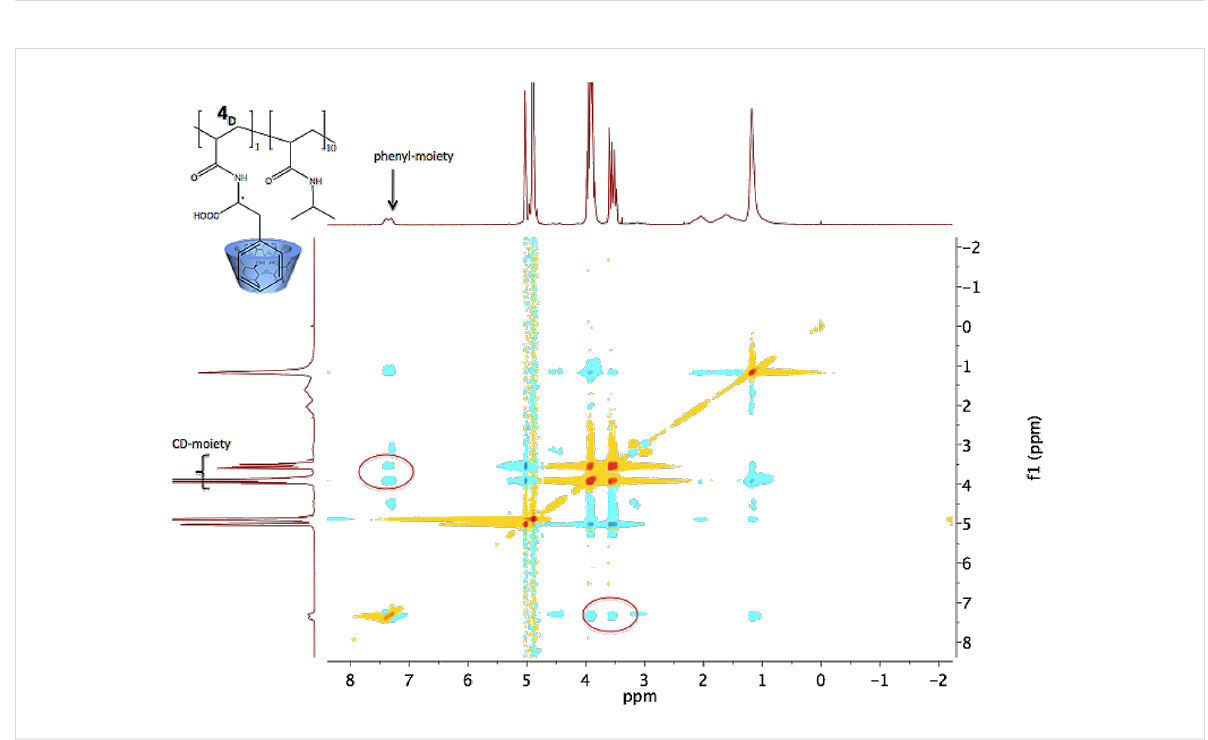
Figure 1: 2D NMR ROESY spectrum of monomer 2 D with RAMEB-CD.